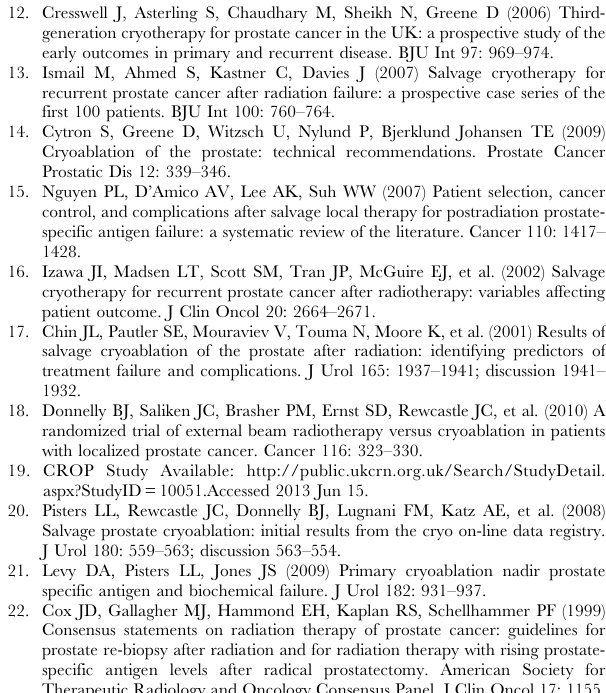
Figure S1 Data on pre and post-SCT nadir PSA levels for each of the three participating centres. (GLA – Glasgow, SUN – Sunderland, GUIL – Guildford.). Figure S2 Gleason scores of radiation recurrent pros- tate cancer prior to SCT are shown for each the three centres. (GLA – Glasgow, SUN – Sunderland, GUIL – Guildford.). Figure S3 Pre and (3-month) post-SCT IPSS levels for the Glasgow cohort. Table S1 Summary demographics from the three participating centres.